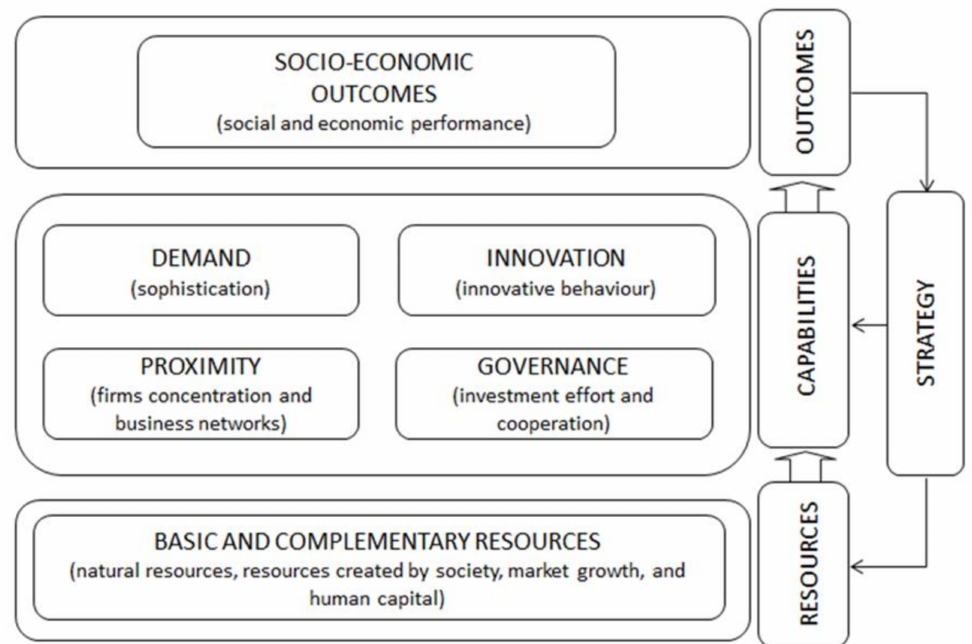
Figure 1. Model of territory competitiveness from the resource-based